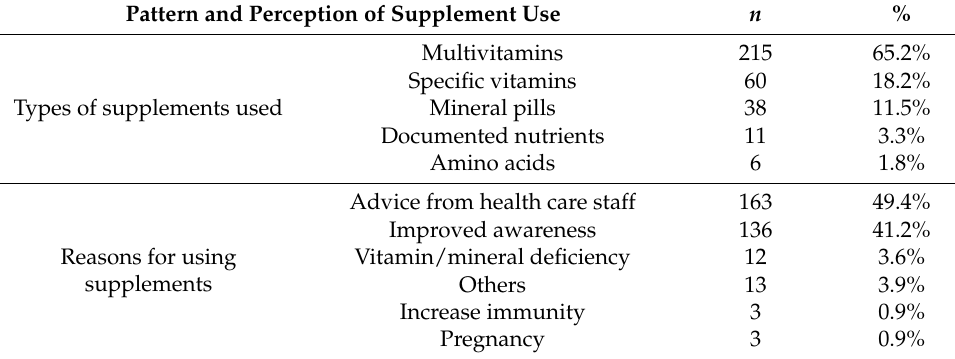
Table 1. Pattern and perception of use of dietary supplements among users (330) attending PHCCs in Abha, Saudi